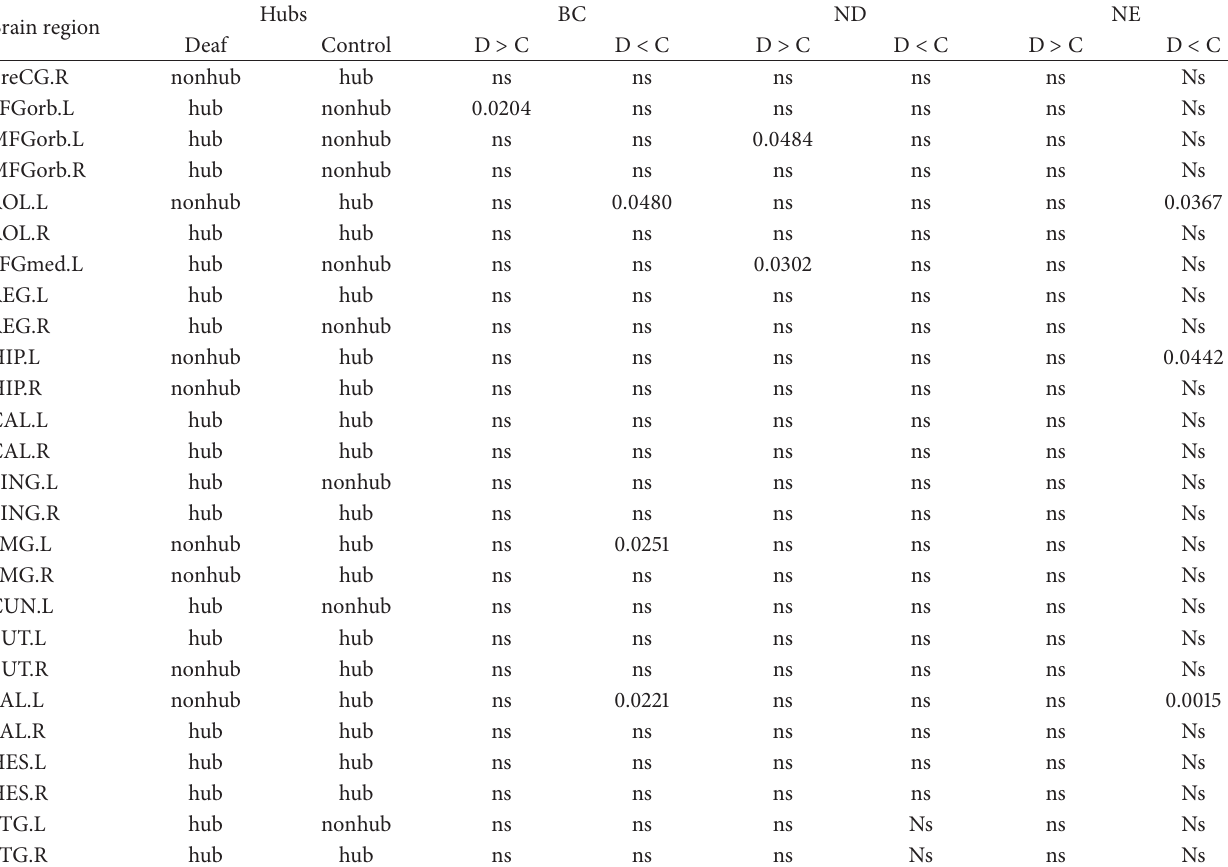
Table 3: Group differences of nodal topological parameters in hubs (not